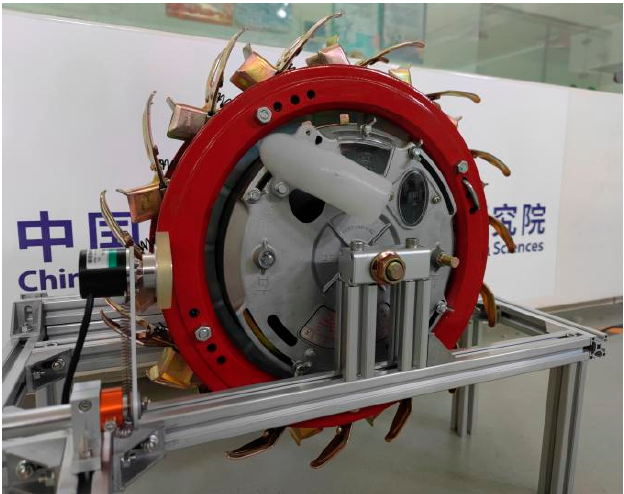
Figure 6. Test bench of the monitoring system.